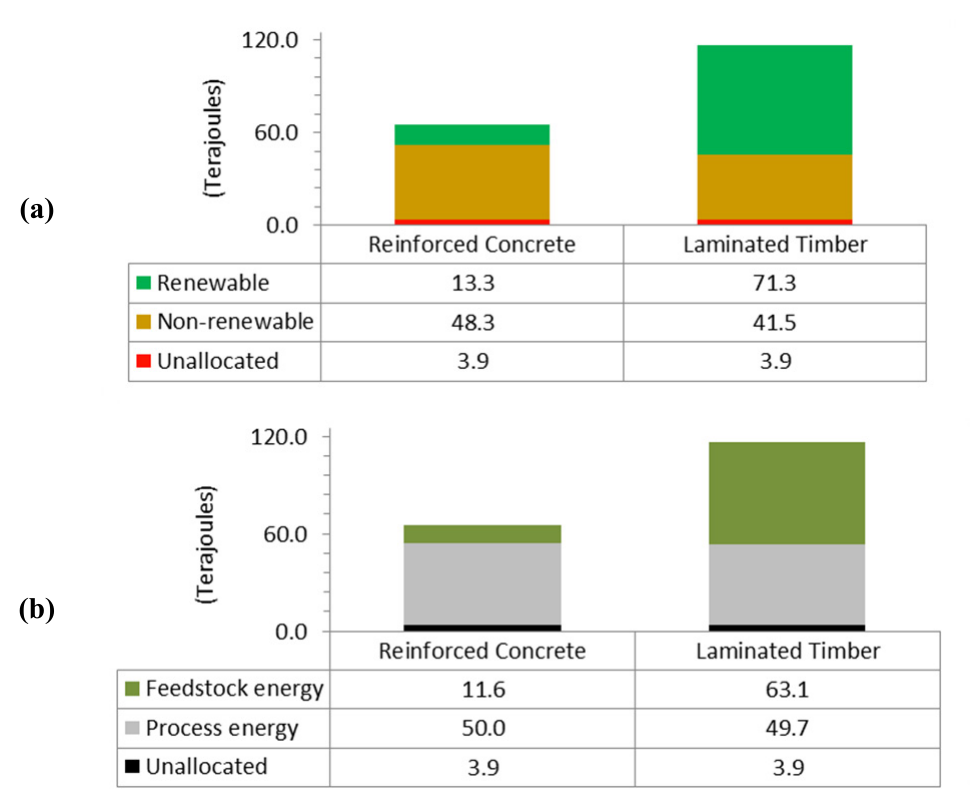
Figure 3. ( a ) Embodied energy of building materials by fuel renewability; ( b ) Embodied energy of building materials (feedstock and process